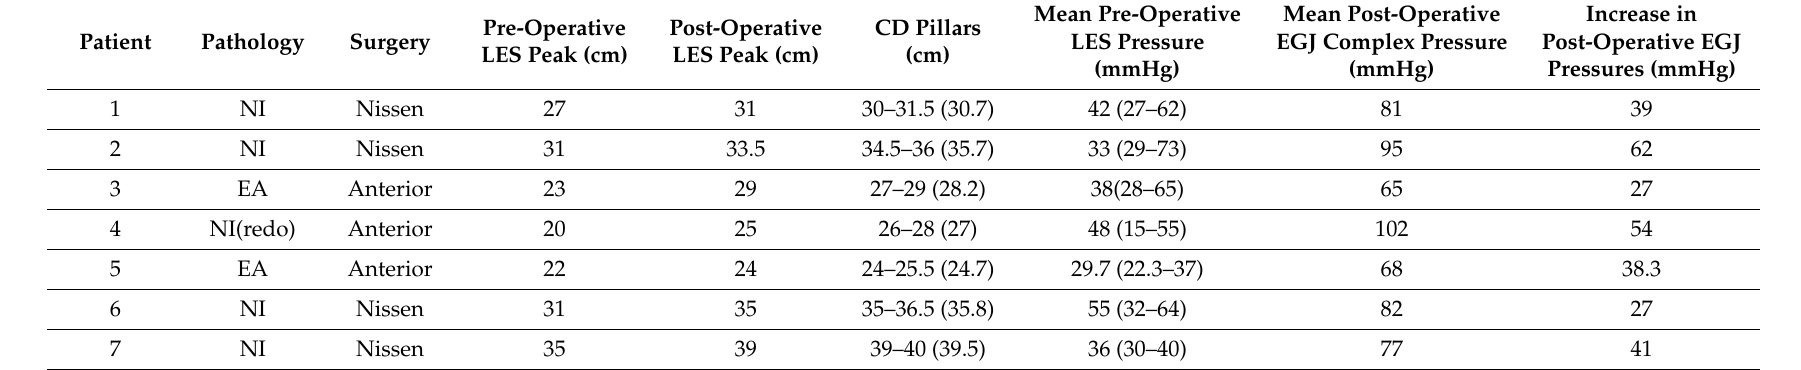
Table 2. Surgical and intraoperative manometric